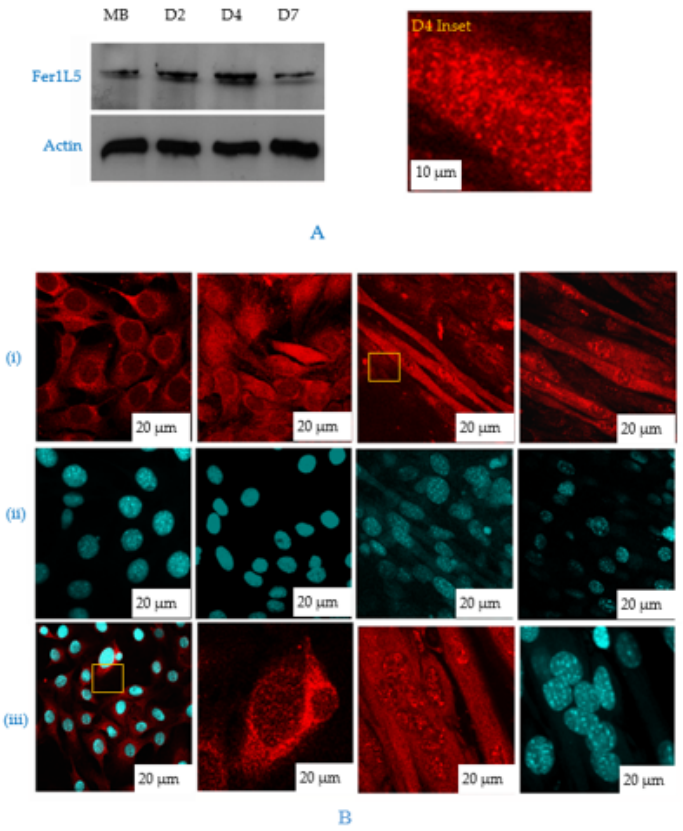
Figure 4. Fer1L5 expression profile during C2C12 differentiation. ( A ) C2C12 lysates collected from